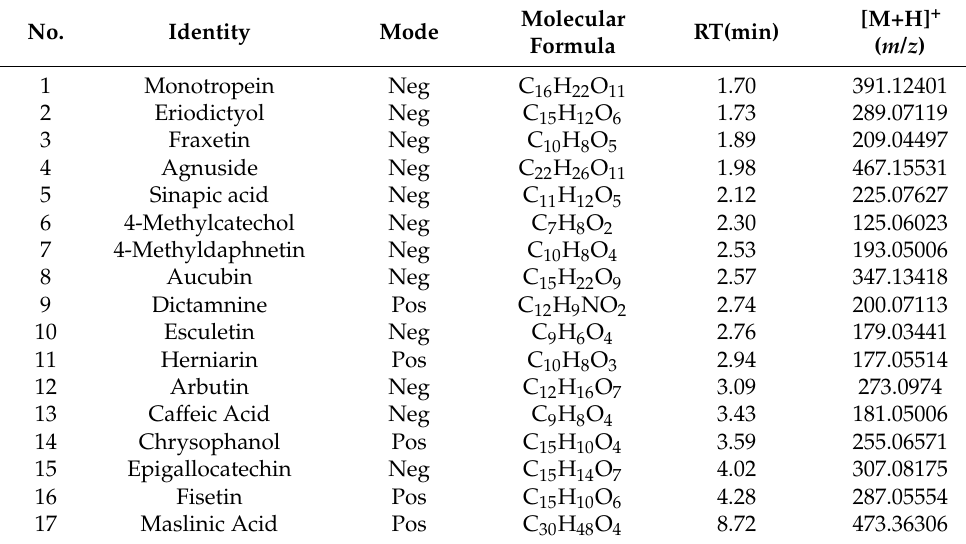
[M+H] + Molecular RT(min) ( m / z ) Formula